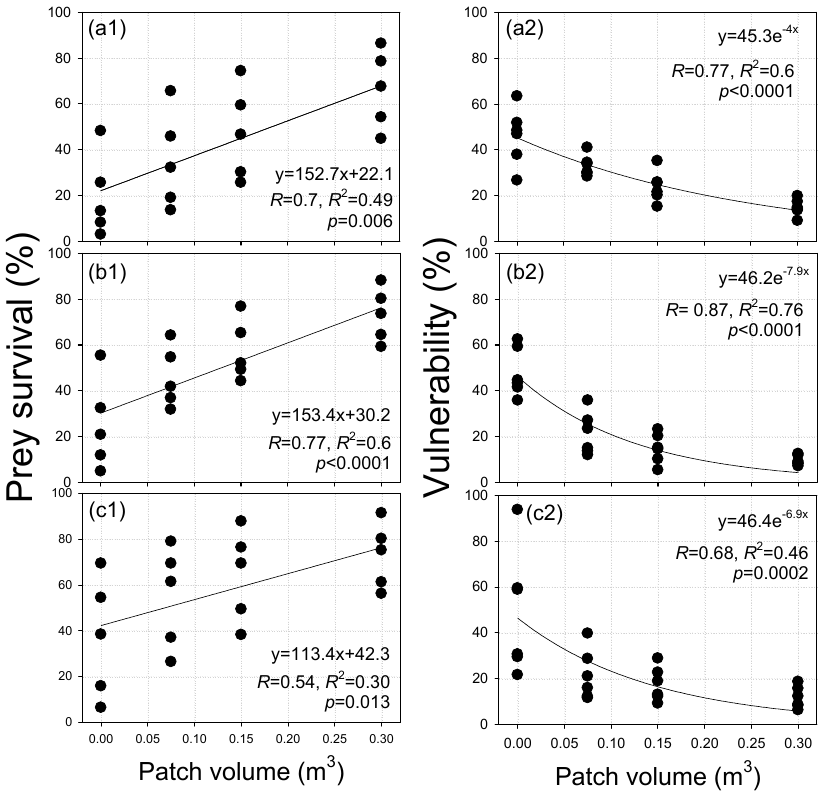
Figure 4. ( 1 ) Changes in prey survival with various patch volumes of JFS; and ( 2 ) changes in vulnerability with various patch volumes of JFS: ( a ) Period 1; ( b ) Period 2; and ( c ) Period 3.